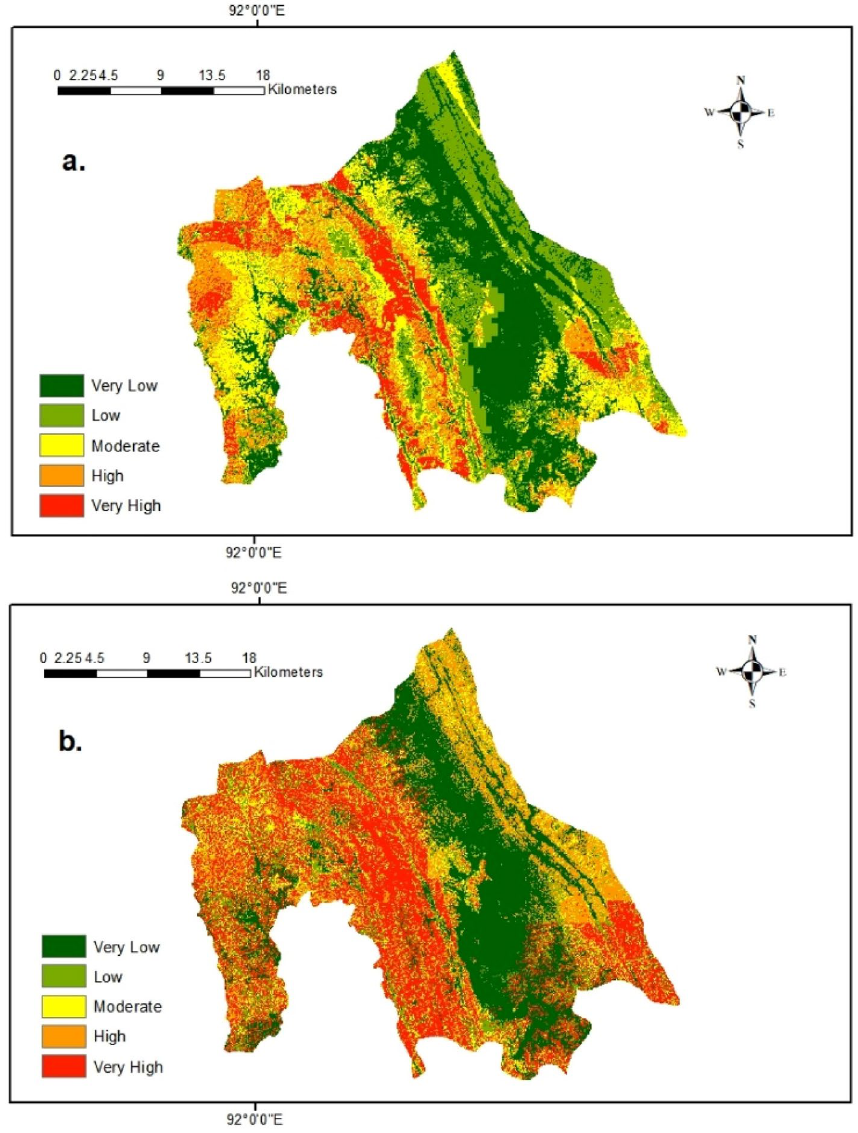
Figure 9. Landslide susceptibility maps based on the random forest model using: ( a ) Mahalanobis distance based absence-data sampling; ( b ) Slope-based absence-data Sampling (Maps were produced using Arcmap